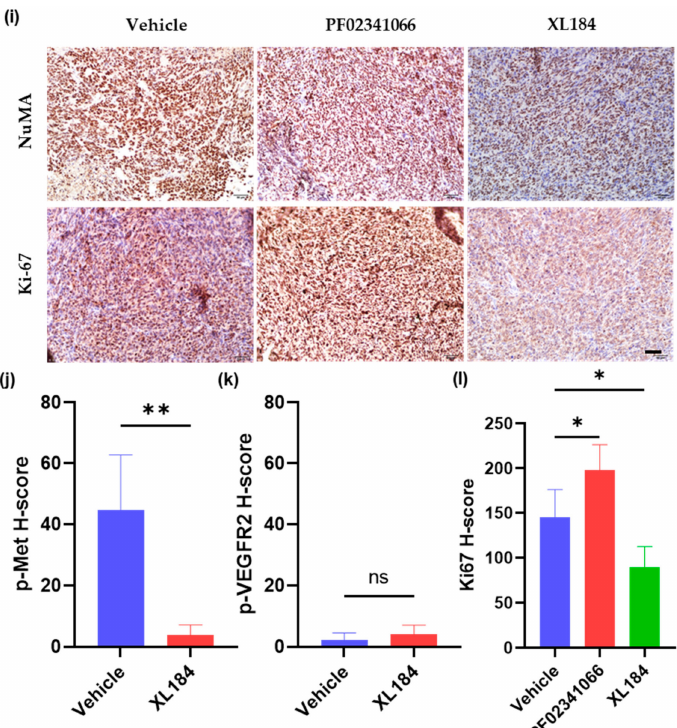
Figure 6. In vivo efficacy of XL184 in MNNG/HOS Luc+ xenograft model. ( a ) CCK8 assay revealed the proliferation of MNNG/HOS cells which were cultured in the presence of the indicated concen- trations of XL184 for 48 h. ( b ) Western blotting analysis on the expression and the phosphorylation of c-Met and VEGFR2 in MNNG/HOS cells cultured in serum-free medium with the indicated concen- trations of XL184 for 48 h. Detailed information about Western blot can be found at supplementary materials. ( c ) Treatment schema. Treatment started on day 10 when the tumors reached about 0.5 cm in largest diameter after tumor inoculation. Mice then received oral gavage of PF02341066 and XL184 (50 mg/kg) every other day. Tumor growth was measured using a vernier caliper dur- ing 2-week treatment and monitored by bioluminescence imaging. ( d ) The tumor size of each mouse was measured and performed as the tumor volume (cm 3 ) on the indicated day. Mean ± SD, n = 5. ** p < 0.01, *** p < 0.001 by one-way ANOVA. ( e ) In vivo bioluminescence imaging of BALB/c athymic nude mice bearing MNNG/HOS-Luc+ xenografts on day 22. ( f )